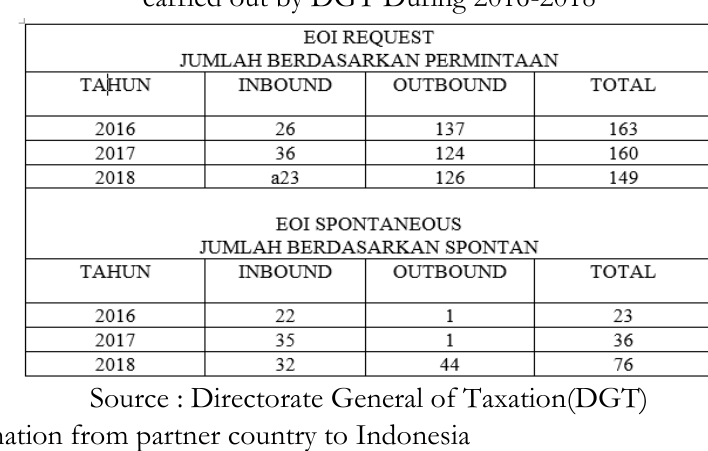
The amount and type of information exchange that has been carried out by DGT During